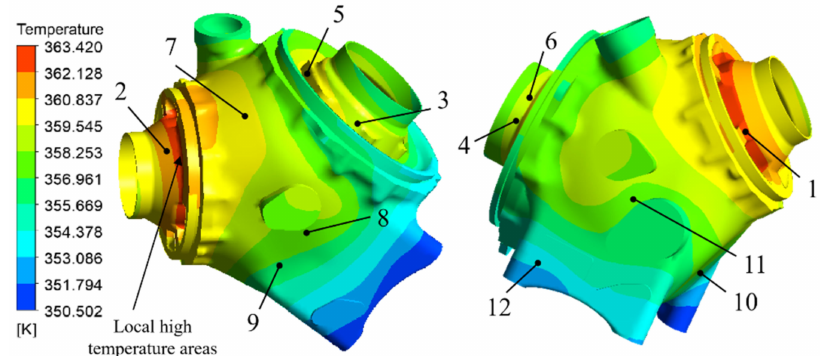
Figure 10. Temperature distribution of casing and end covers.